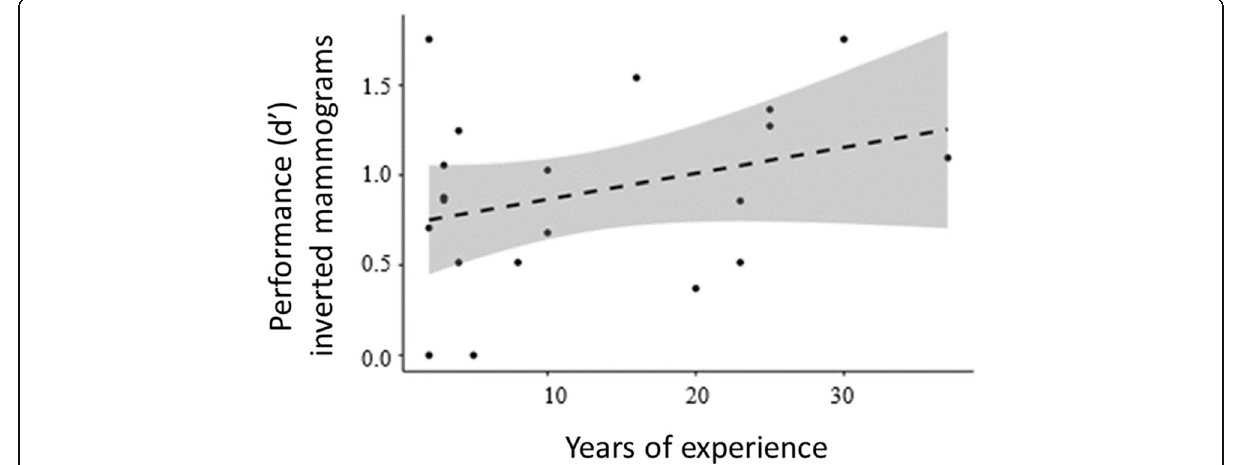
Fig. 5 Performance d ’ scores of inverted mammogram stimuli across years of radiology